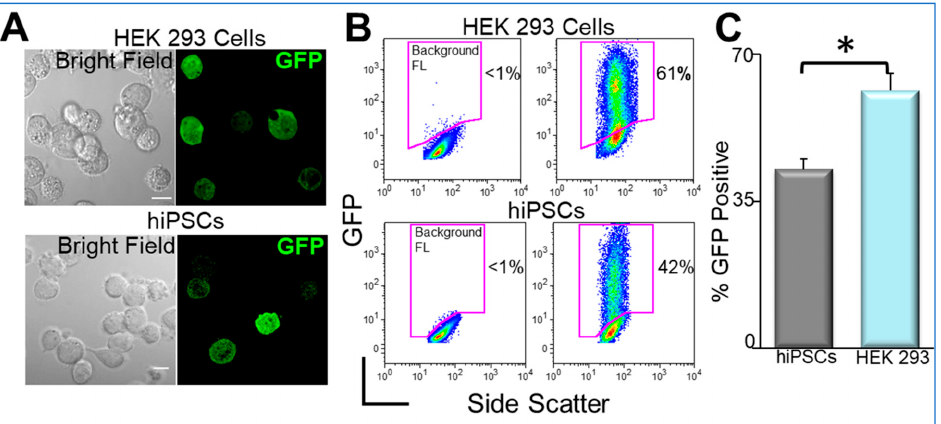
Figure 7. Transfected cells and the flow cytometry analysis of the transfection efficiency [78]. ( A ). Confocal laser scanning microscopic images of double fusion construct-transfected HEK 293 cells (upper) and human induced pluripotent stem cells (hiPSCs) (lower). The left panels show the corresponding bright-field images of the cells. Scale bar is 10 µm. ( B ). Flow cytometric analyses of transfection efficiencies. Magnetic nanoparticle-treated cells without green fluorescence protein (GFP) plasmids were used as control for background fluorescence (Background FL) shown in the left panel. GFP signals were detected from the GFP expression in the cells. ( C ). Summary data from D (* p < 0.05, n = 3 − 7).